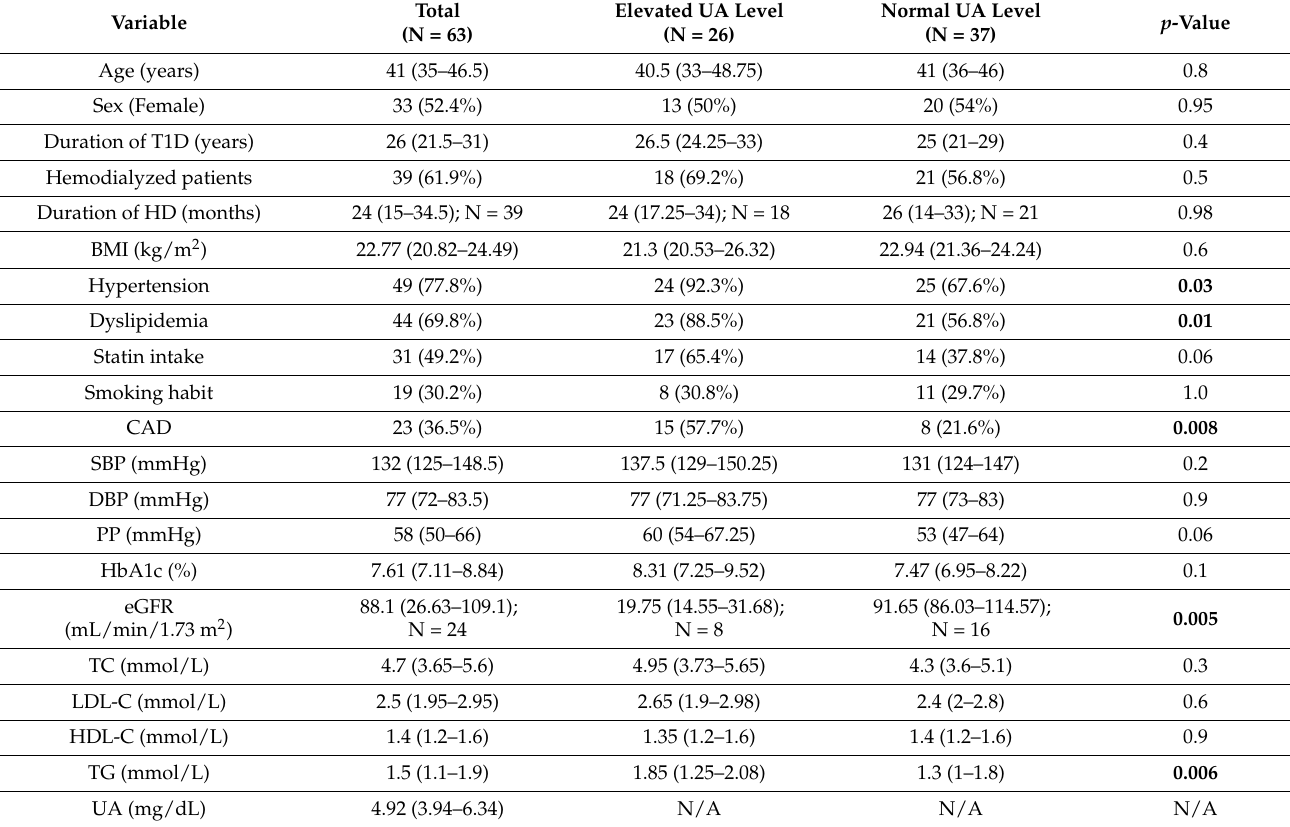
Table 1. Characteristics of the study group stratified by the uric acid levels